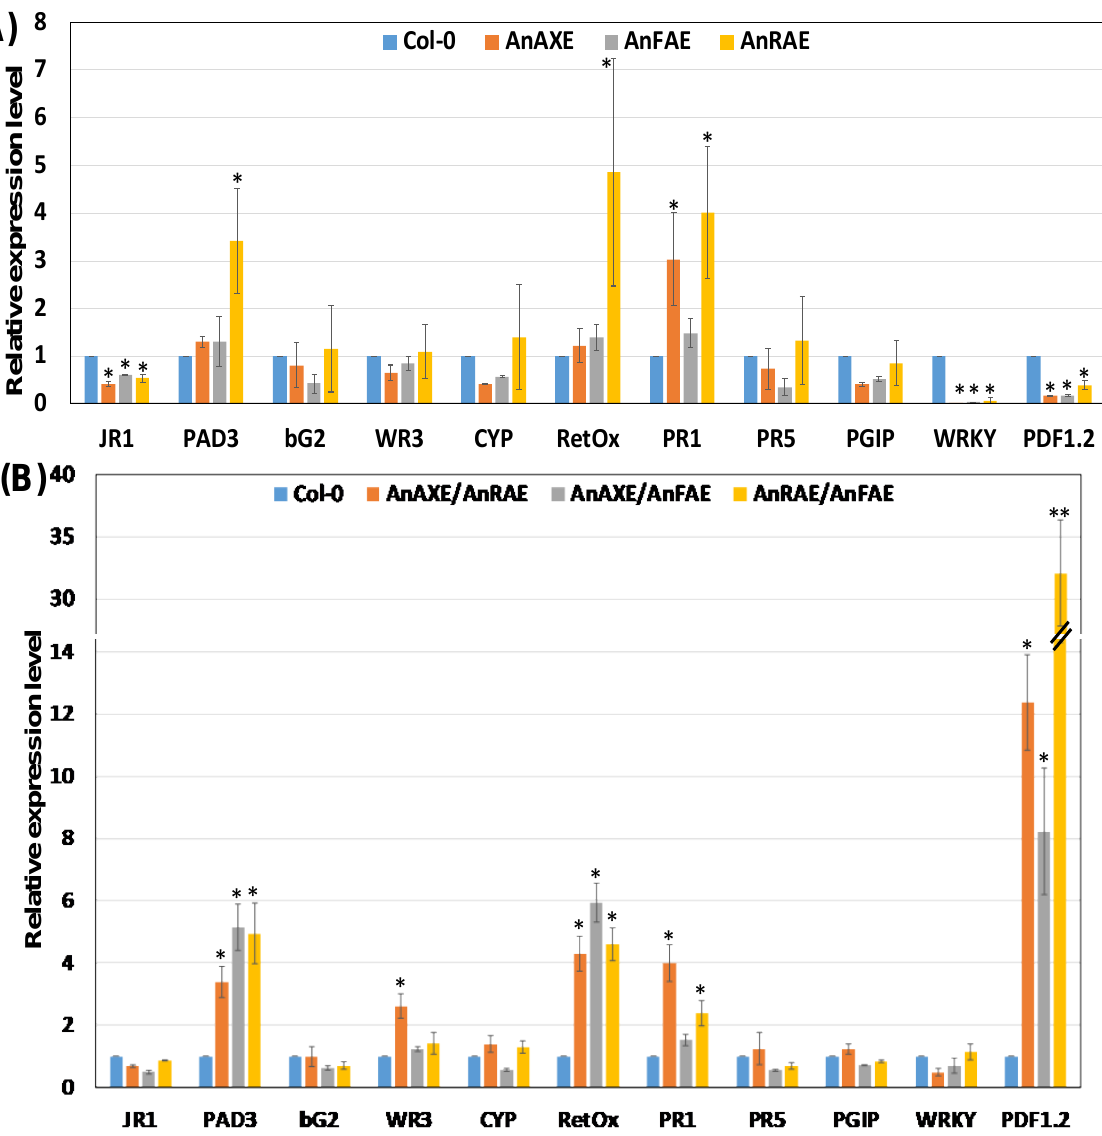
9 of 17 Figure 3. Bioassay of Arabidopsis transgenic plants against the fungal pathogen, Botrytis cinerea . Three-week-old uniform Arabidopsis leaves were inoculated with 5 µL droplets of fungal spores (5 × 10 5 conidia mL –1 ) and examined 48 h post inoculation (hpi). ( A ) Measurement of lesion size on Arabidopsis leaves (48 hpi). Lesion sizes were measured by ImageJ software. Asterisks indicate sta- tistical significance by Fisher’s LSD test ( p < 0.05). ( B ) Extent of symptom development due to B. cinerea infection on Arabidopsis leaves (48 hpi; representative images shown). 3.5. Deacetylation and Deferuloylation of CW Resulted in Expression of Pathogen-Responsive Genes To determine whether overexpression of acetylesterases/feruloylesterase and the re- sultant decrease in CW acetylation/feruloylation constitutively primed the plant defense pathways, transcript levels of defense pathway-related genes were measured by RT-qPCR in healthy, uninfected Arabidopsis plants. In Arabidopsis transgenic plants expressing